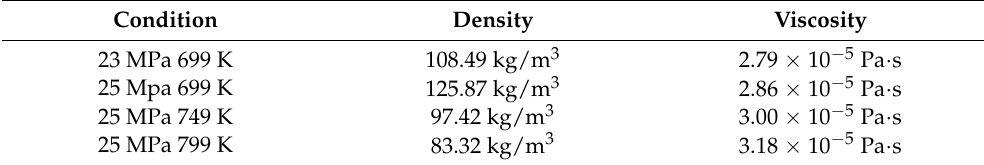
Table 3. Physical properties of SCW under different pressure and temperature conditions.